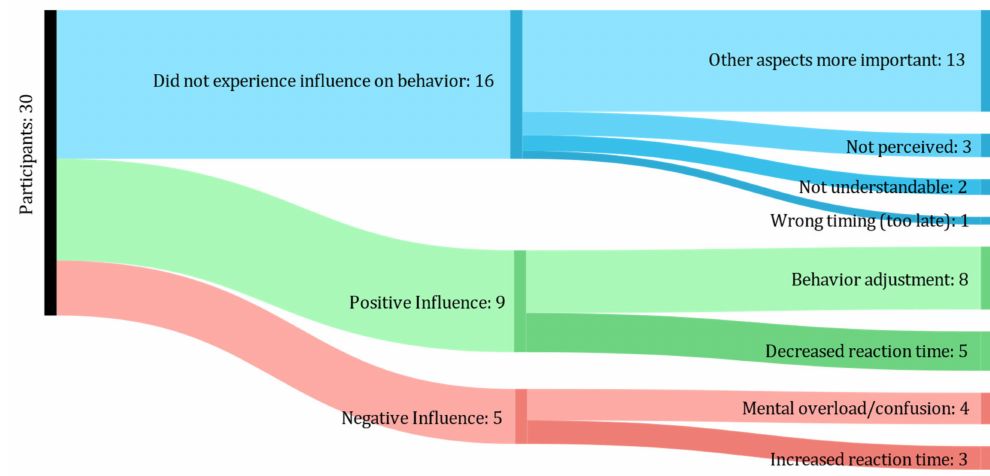
Figure 9. Frequencies of participants’ answers to interview question 1: did the external communication of the AS influence your behavior? How? Why [not]?